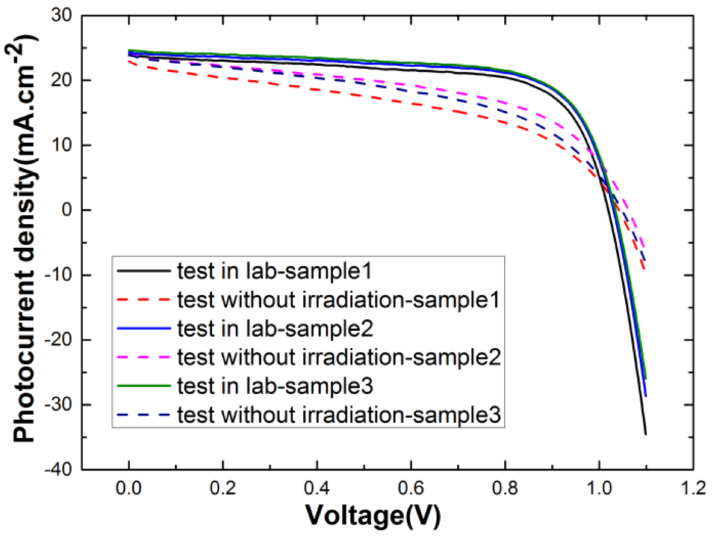
Figure 2. J–V curves of control groups were tested in the lab and natural environment without